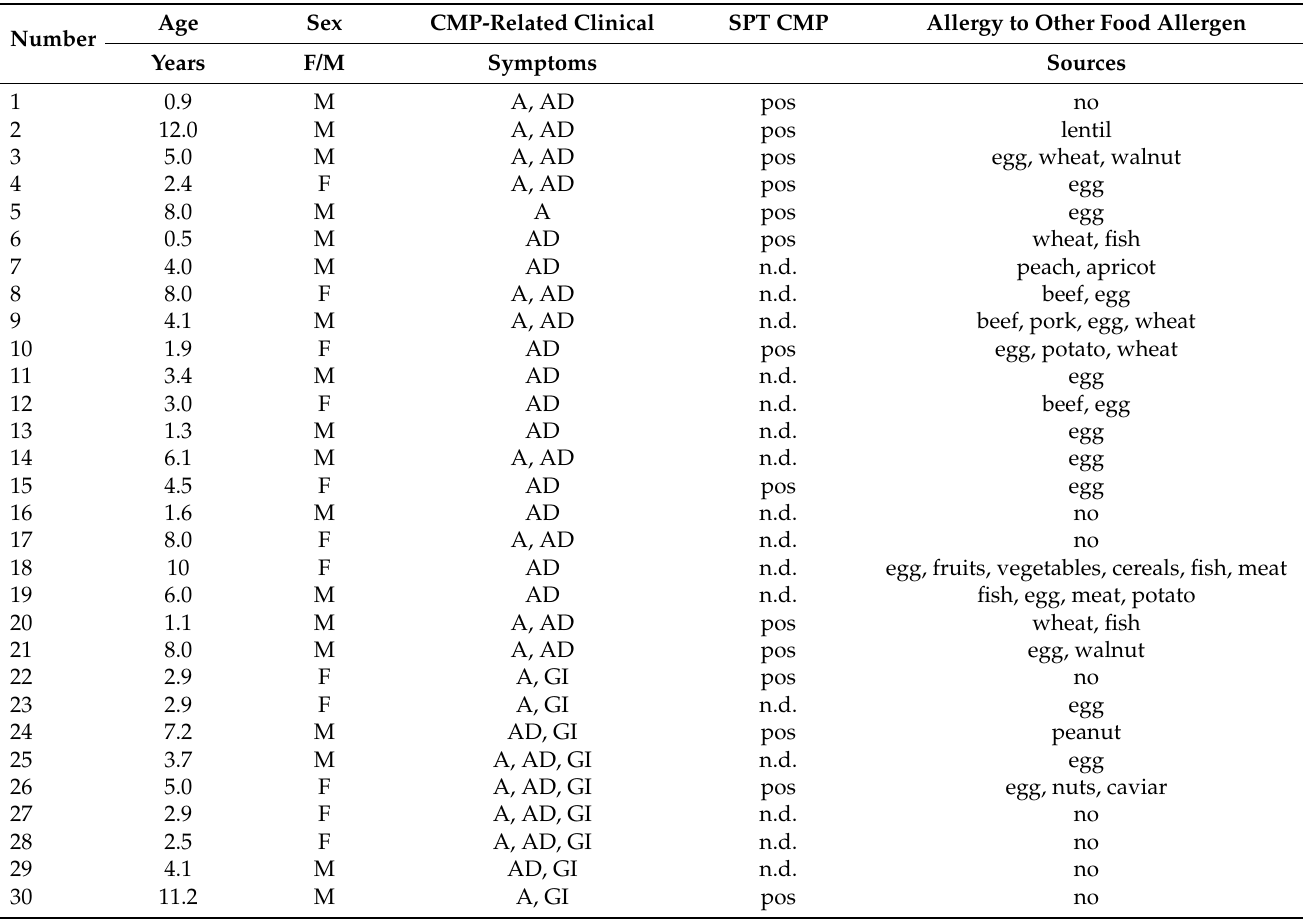
Table 1. Demographic and clinical characteristics of allergic patients and of non-allergic